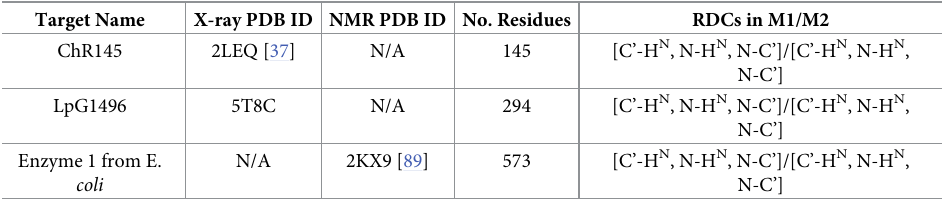
Table 5. List of protein targets used in the synthetic study of large